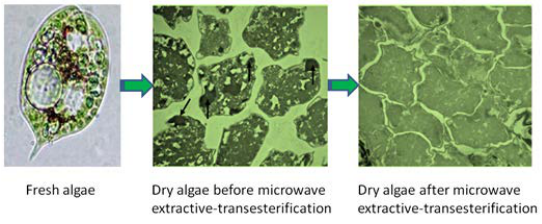
Figure 6. Microwave assisted lipid extraction from algal biomass